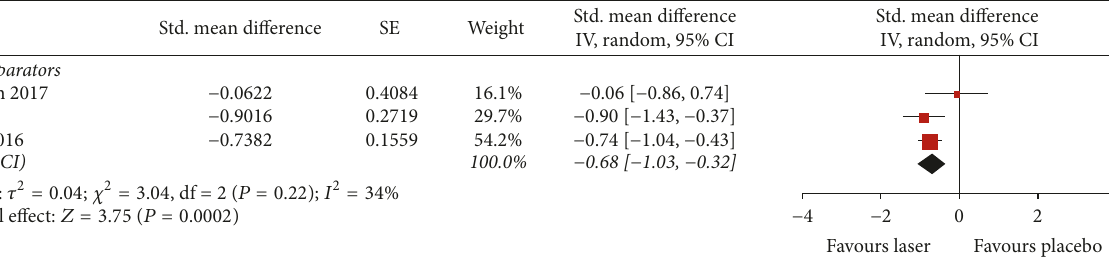
Figure 6: Forest plot of pooled standard mean difference in chewing pain at 72